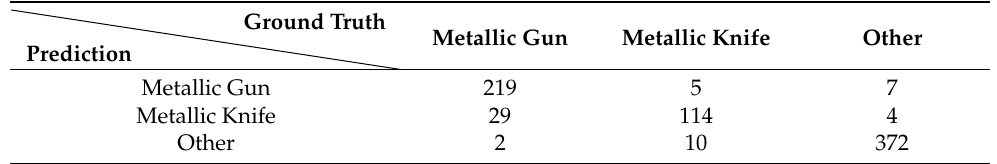
Table 4. Confusion Matrix of Threat Classification on